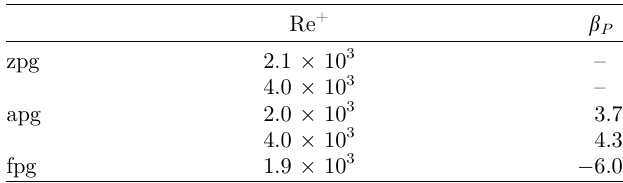
Table 1. Parameters of the experimental data [29] used in Figure 7.